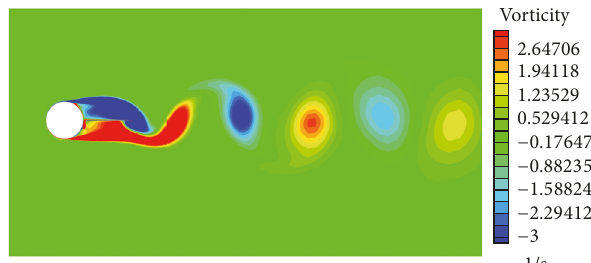
Figure 16: A contour of vorticity with a dimensionless plate length of 1.25 and a damping value of